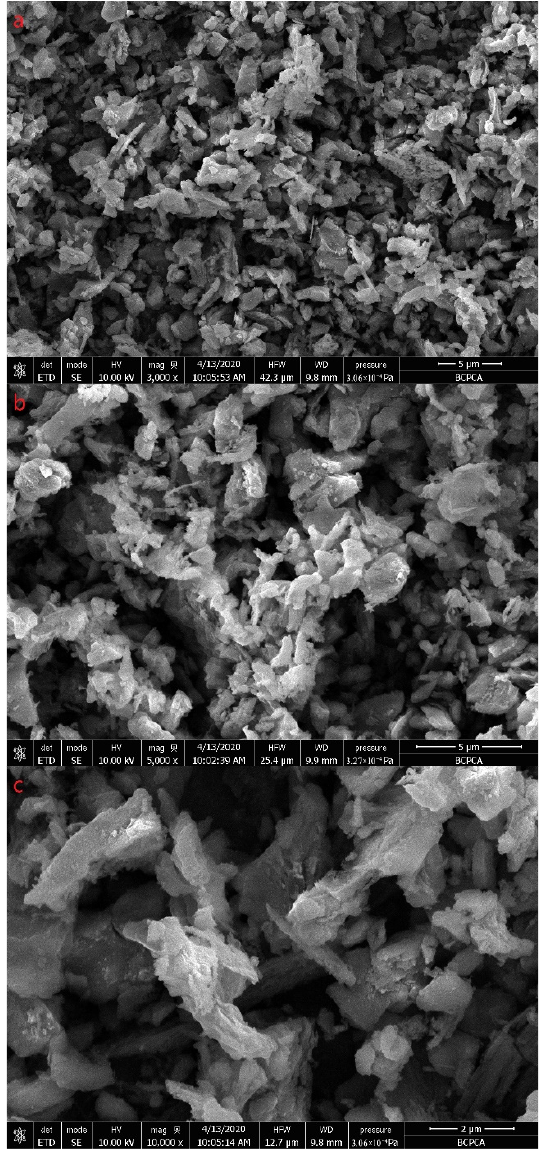
Figure 3. SEM images of the purification products. The magnification of ( a ) is 3000, the magnifica- tion of ( b ) is 5000, and the magnification of ( c ) is 10,000. of ( b ) is 5000, and the magnification of ( c ) is